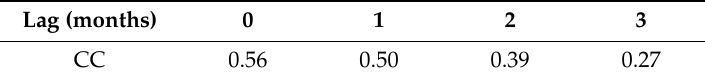
Table 1. The correlation coe ffi cients (CCs) with di ff erent delays between the NDVI and the observed precipitation at all stations during the warm seasons from 2014 to